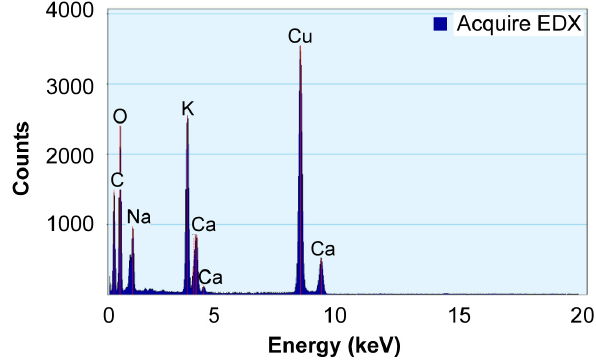
Figure 6: EDX analysis results of the MC-MWCNT suspension